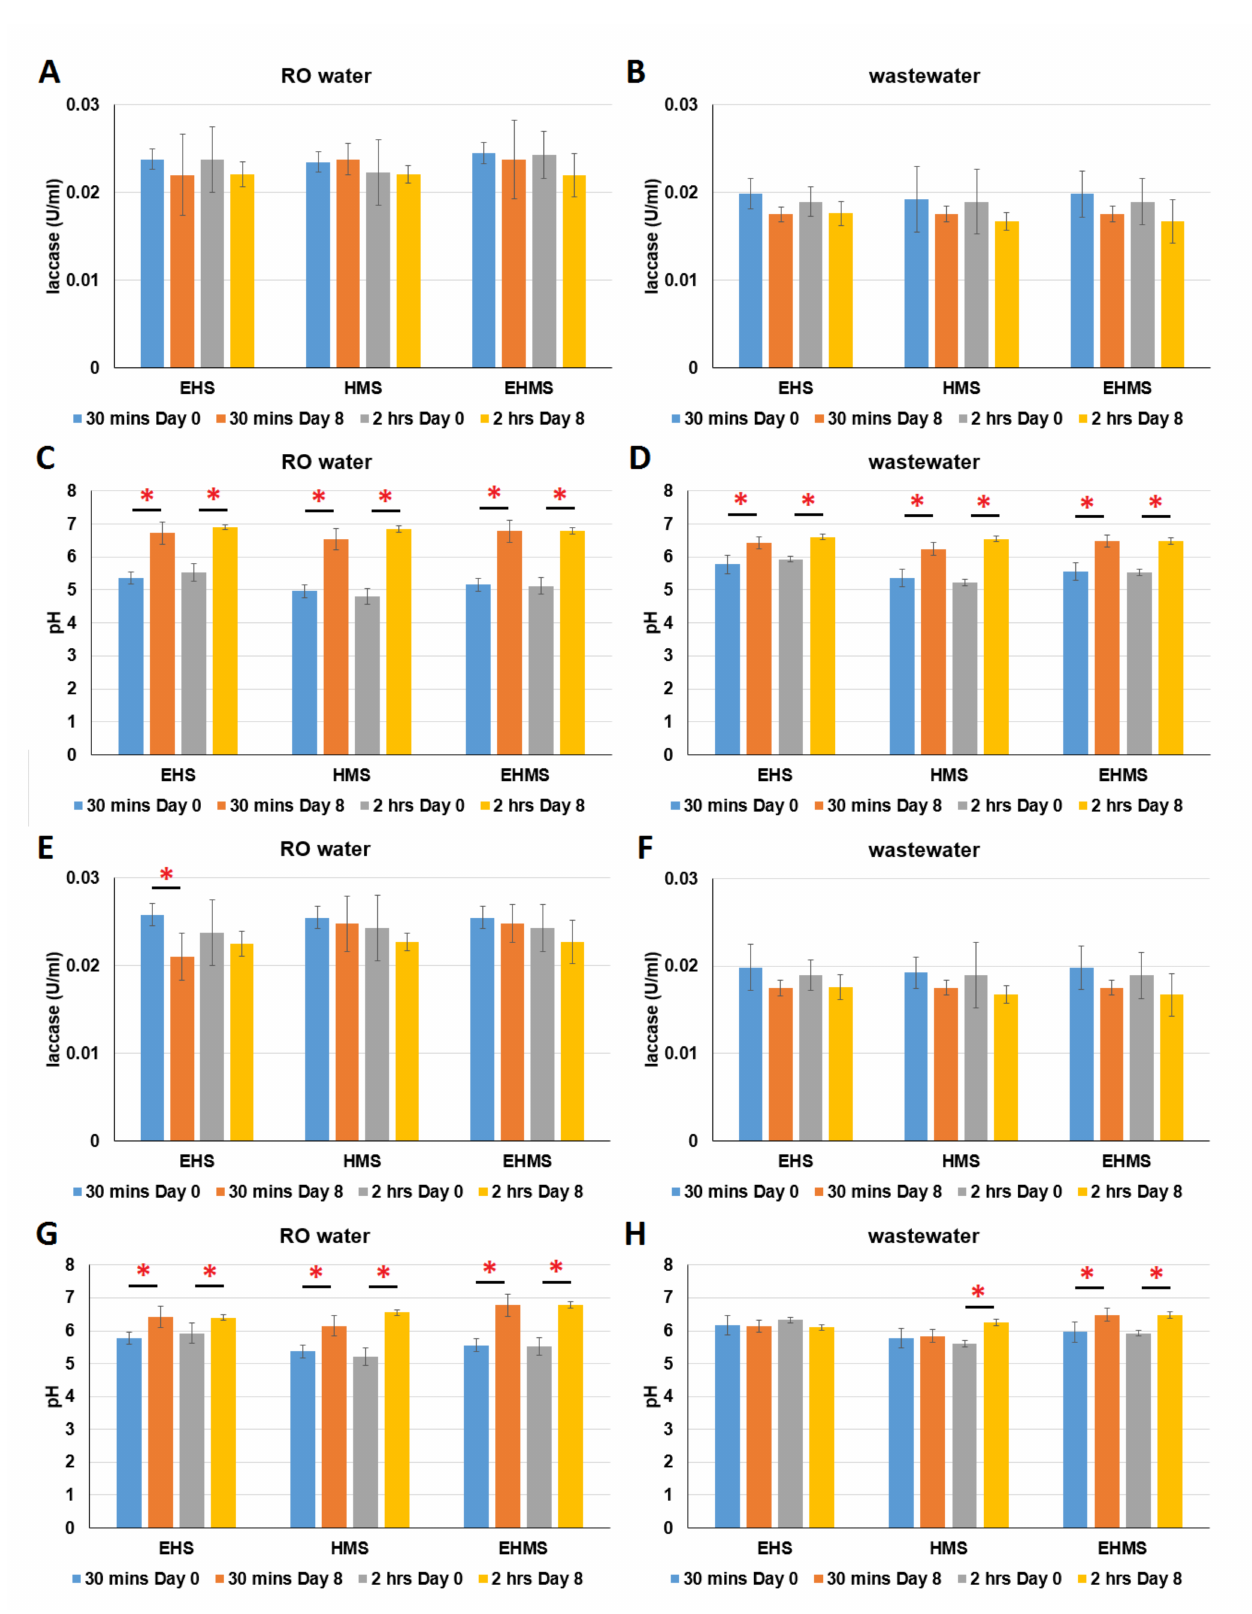
Figure 9. Laccase activity and pH values of the enzyme extracts before (day 0) and after (day 8) the bioreactor experiments. Bioreactor experiments simulating UV filter removal in reverse osmosis (RO) filtration water and wastewater using the spent mushroom compost of two mushrooms ( Pleurotus eryngii ( A – D ) and Pleurotus djamor ( E – H )). Data from triplicate experiments are presented as the mean ± SE. EHMC: ethylhexyl methoxycinnamate, EHS: 2-ethylhexyl salicylate, HMS: homosalate. Red stars indicate the p values of t tests <